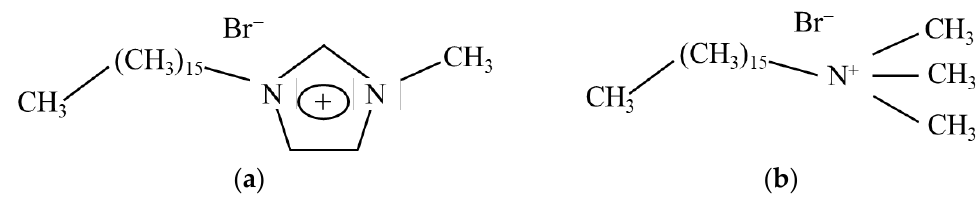
Figure 1. Chemical structures of ( a ) C 16 mimBr and ( b ) CTAB.